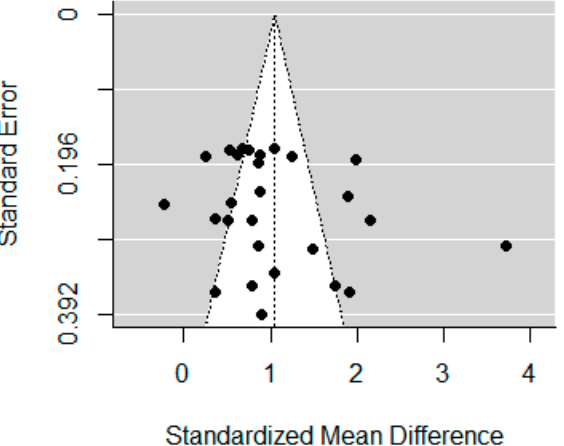
Figure 5. Funnel plot for studies included in the self-report impulsivity meta-analysis.